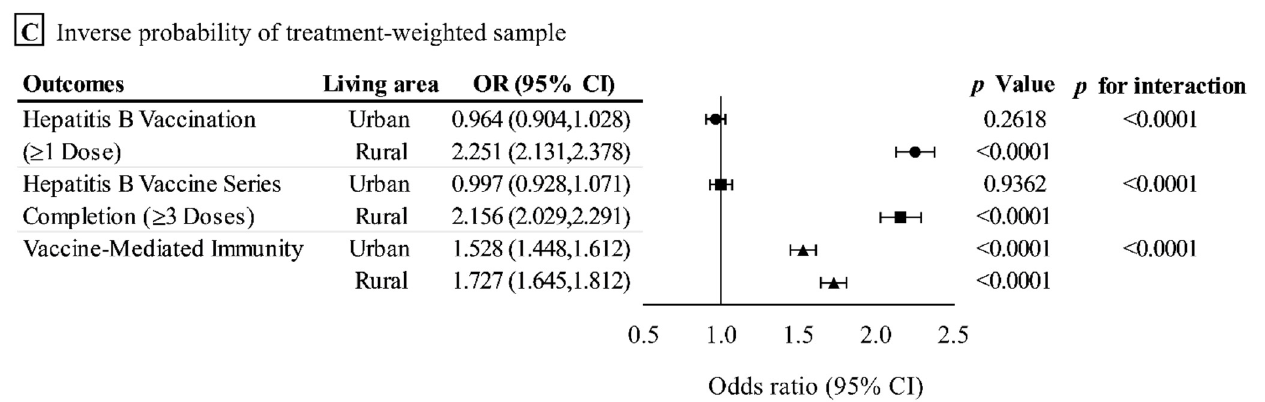
Figure 3. Association between HBVIDV program and outcomes in original sample ( A ), propensity score–matched sample ( B ) and inverse probability of treatment–weighted sample ( C ), stratified by living area. a Odds ratios were adjusted for age, gender, educational level, employment condition, economic level, self-rated socioeconomic status, multimorbidity, self-rated health condition. Table 2. Association between HBVIDV program and